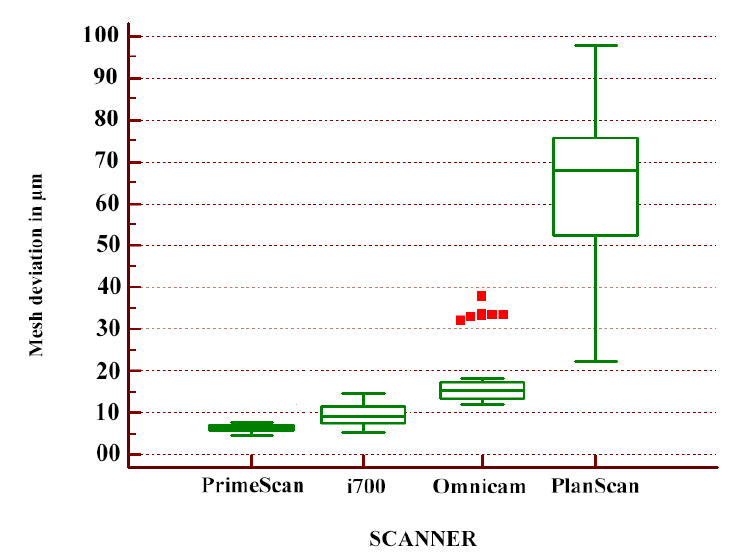
Figure 4. Boxplot displaying the precision values of the four intraoral